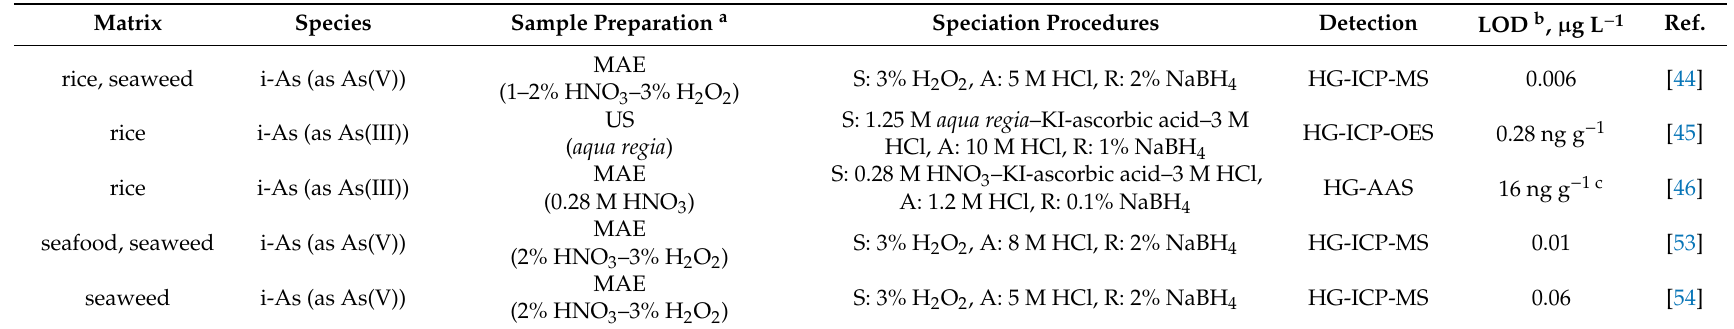
Table 3. Non-chromatographic procedures for operational speciation, i.e., i-As determination (total As(III) and